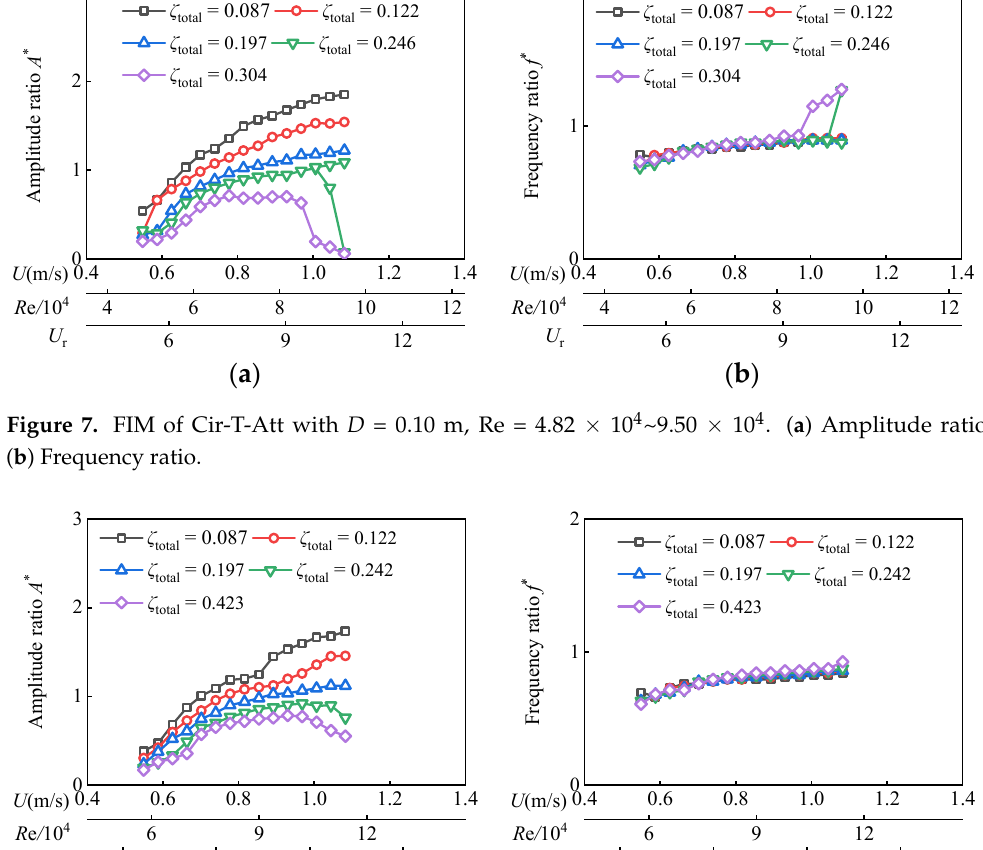
Figure 7. FIM of Cir-T-A tt with D = 0.10 m, Re = 4.82 × 10 4 ~9.50 × 10 4 . ( a ) Amplitude ratio. ( b ) Fre- quency ratio.